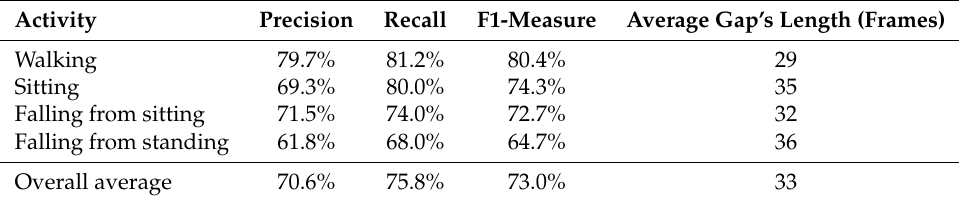
Table 5. The recognition results of the four fall-related activities from partially-observed videos when the missing subsequence of frames is at the end of the testing video